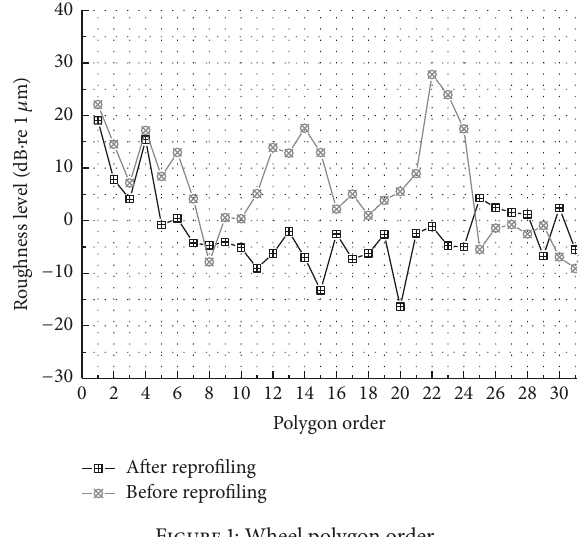
Figure 1: Wheel polygon order.